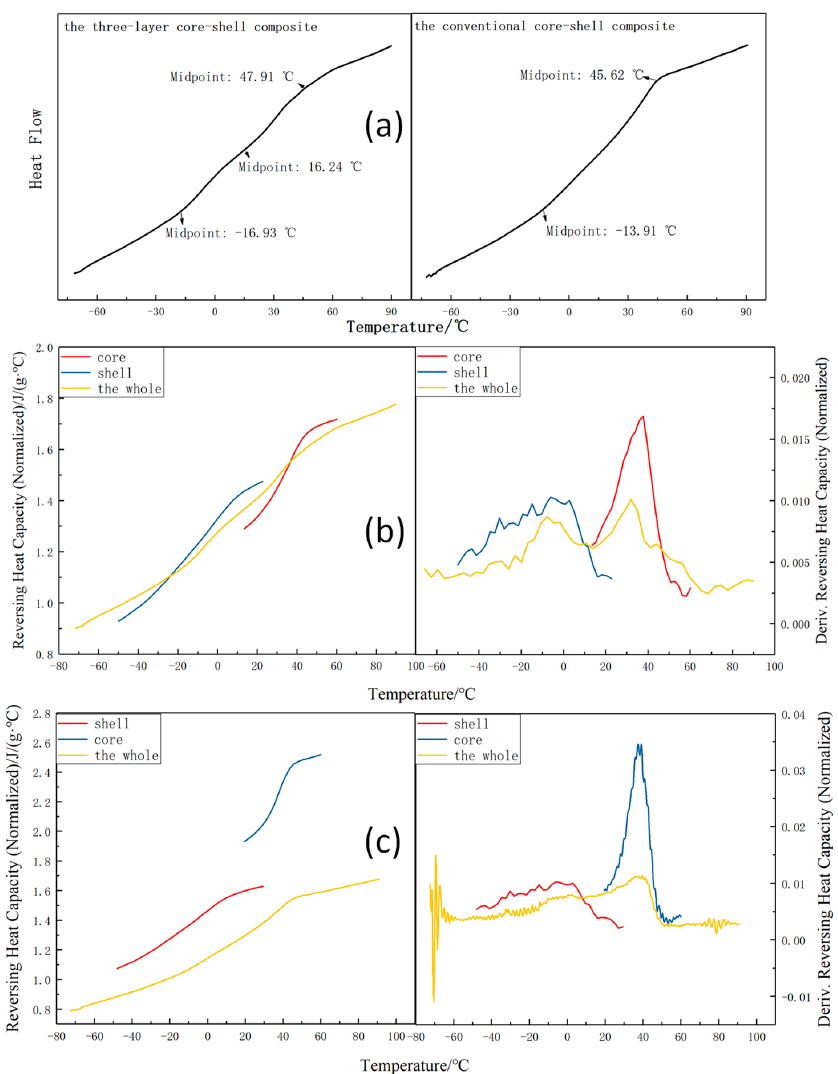
Figure 6. DSC curves and TOPEM-DSC curves of waterborne epoxy-styrene–acrylate composite emulsion film: ( a ) DSC curves; TOPEM-DSC curves of ( b ) three-layer core-shell structure and ( c ) conventional core-shell structure. (15% modified E-44, the whole: whole latex particle, core: pure core polymer, and shell: pure shell